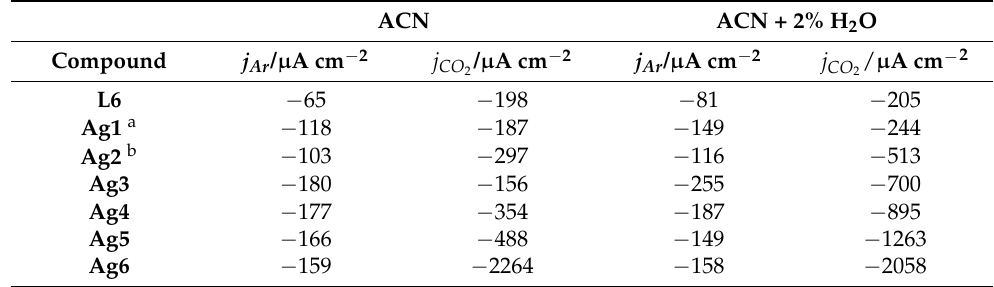
Table 3. CV current densities (0.28 cm 2 glassy carbon WE) of 1 mM BIAN ligand L6 and Ag(I) bis- BIAN complexes Ag1 – Ag6 under argon or CO 2 in anhydrous acetonitrile solutions or with addition of 2% H 2 O at a potential of − 1.90 V vs. NHE and cathodic scan rate of 100 mV s − 1 . ACN + 2% H 2 O